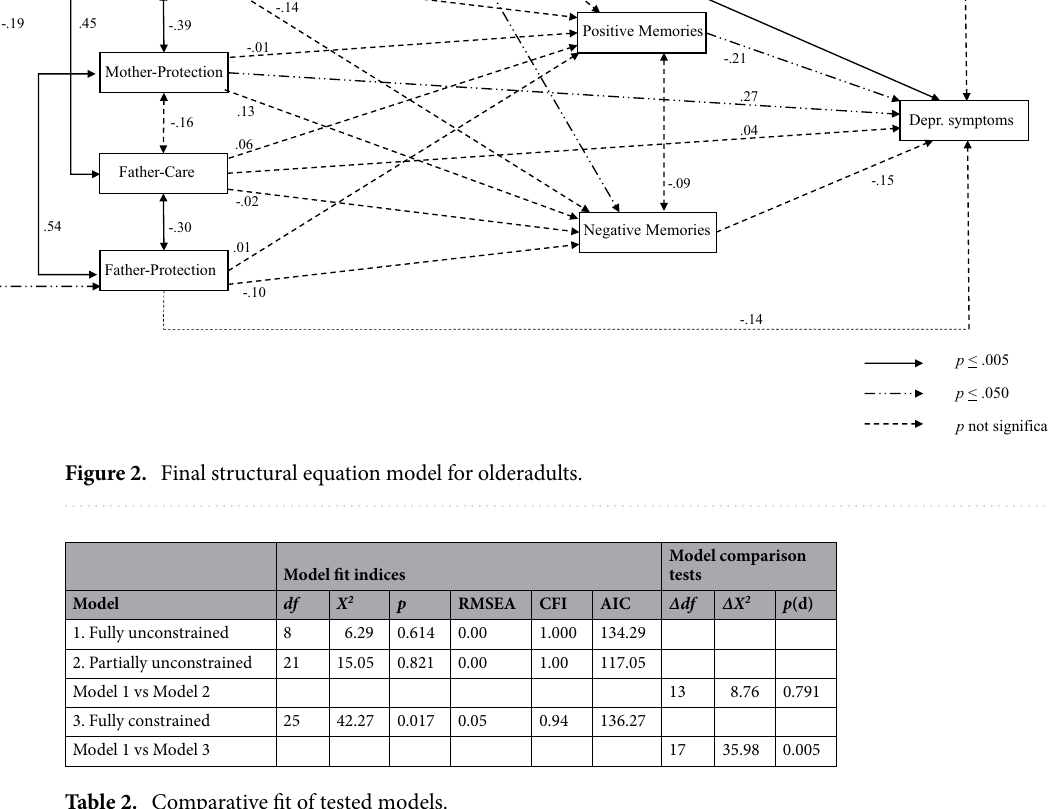
Table 2. Comparative fit of tested